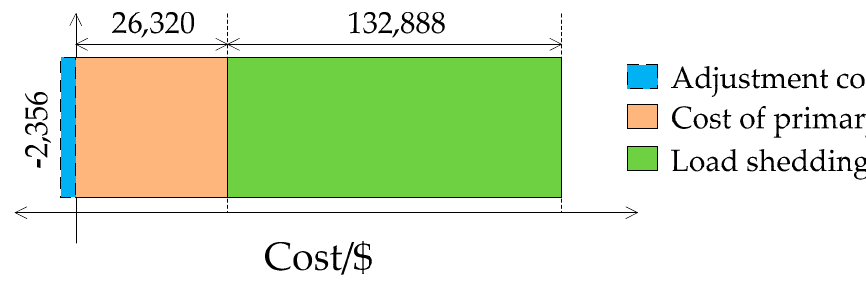
Figure 6. Classification of real-time operating costs.